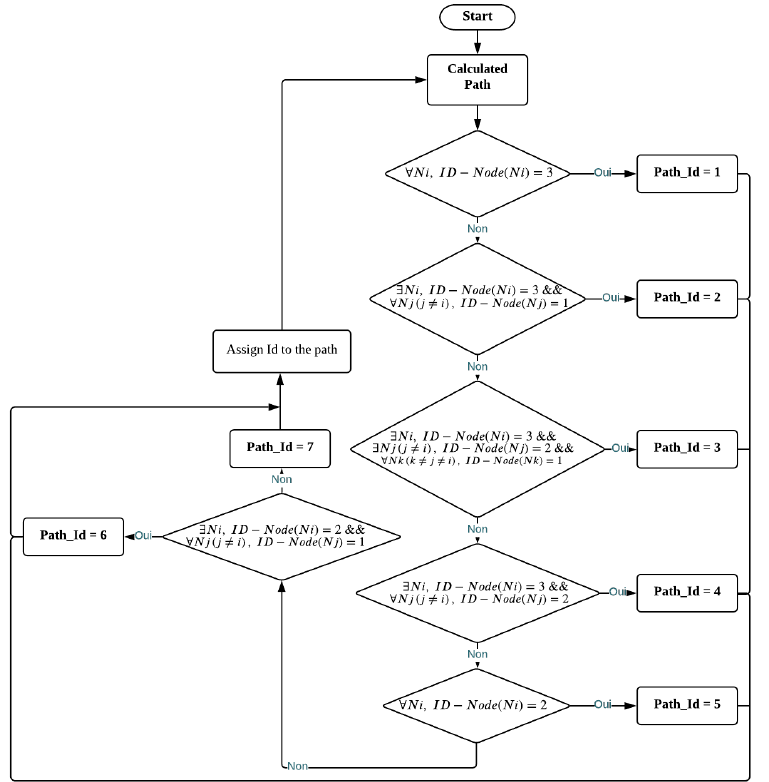
Figure 7. Path classification